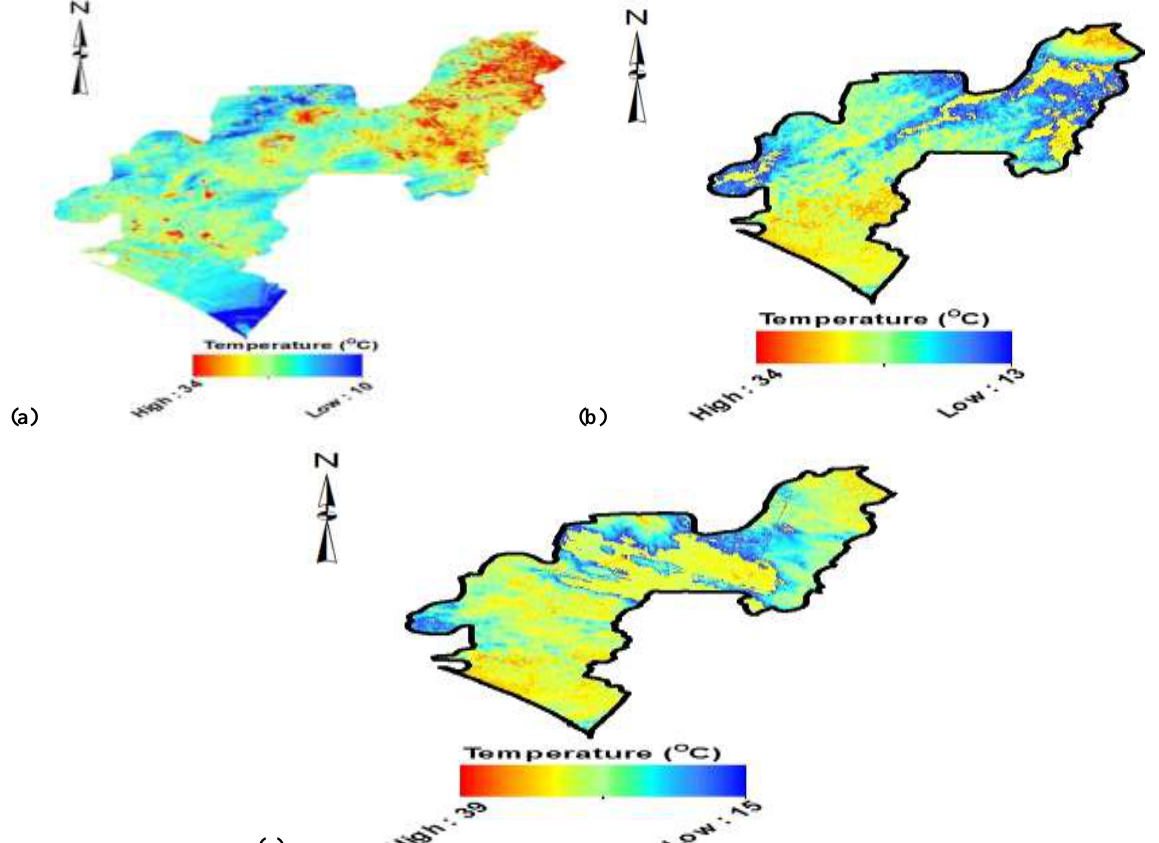
Figure 8: Inter-seasonal variations of spatial patterns of surface temperature in Ondo State: (a) January (b) March and (b)